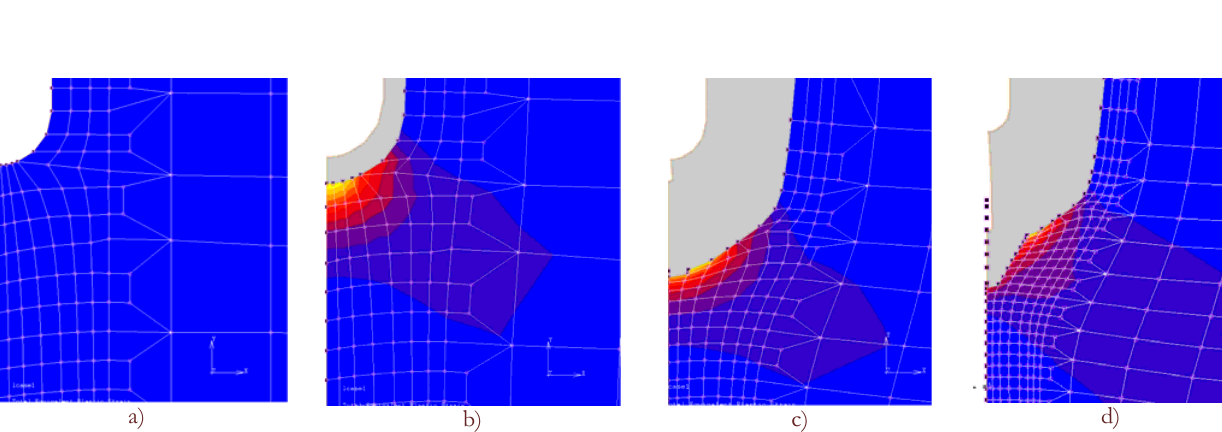
Figure 4: Evolution of damage development at the crack tip of CCB a/R=0.2 under remote tension load: a) initial configuration; b) blunting development; c) crack initiation; d) crack propagation